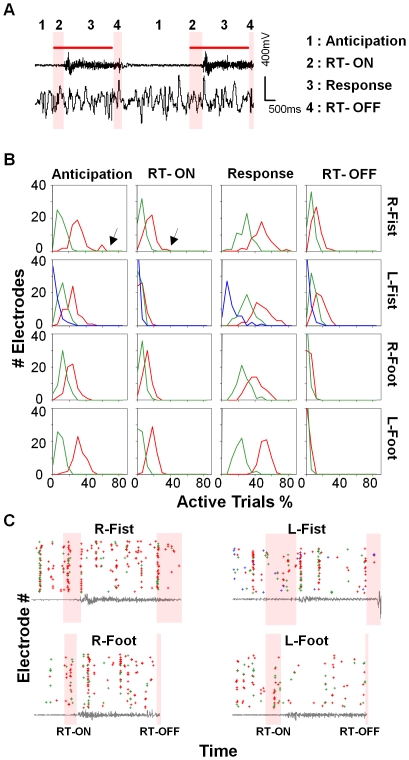
Trial-spanning clusters span all intervals.(A) EMG recordings (above) and corresponding ECoG recordings at one electrode (below) for 2 consecutive trials. Red bar indicates the visual cue for behavior. The EMG amplitude was used to define the start and stop of the motor response. Each trial was divided into 4 time intervals – 1, Anticipation (time prior to cue onset) 2, Reaction Time-ON (cue onset to initiation of motor behavior) 3, Response Time (duration of motor behavior) and 4, Reaction Time–OFF (cue off to cessation of motor behavior). Scale Bar Y, 200 mV X, 200 ms. RT-ON and RT-OFF shaded in pink. (B) Distribution of electrode participation across trials for each interval for each behavior (cluster color coding as in Figure 2G). In all clusters, each electrode participated only in a fraction of trials, typically less than 50% in each interval. A bimodal distribution in cluster RH1 (right fist clenching) indicates a small number of electrodes active in a much larger fraction of trials during the Anticipation and RT-ON intervals (marked by arrows). (C) Raster plot with electrodes 1–59 represented along the y-axis shows nLFP peak times in the trial-spanning clusters in a single trial (clusters color-coded as in Figure 2G). EMG traces for the trial shown in grey, RT-ON and RT-OFF shaded in pink.